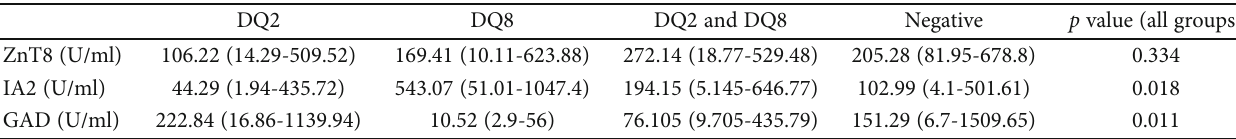
Figure 1: Distribution of HLA haplotypes in group I (T1D) and groups II and III (T1D and CD); p = 0 : 321 Table 2: The association of haplotypes with immunological status (ZnT8, IA2, and GAD titers) — all groups.